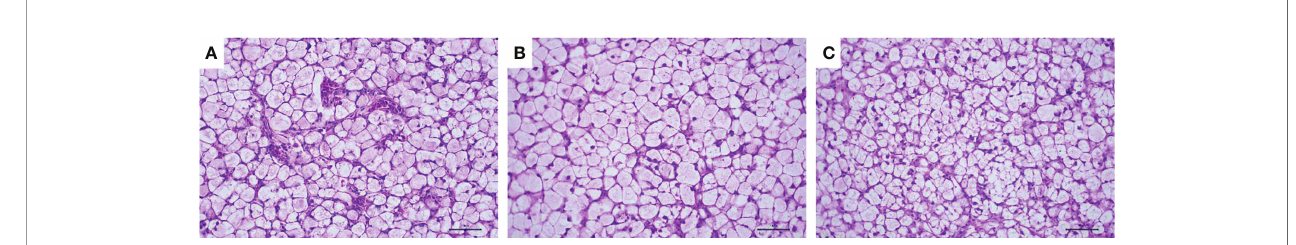
FIGURE 3 | Effect of dietary nano-curcumin on the liver histology (hematoxylin and eosin staining, original magni fi cation ×400) of largemouth bass after 60 days. (A) Liver from fi sh fed diet 0% nano-curcumin. (B) Liver from fi sh fed diet 0.1% nano-curcumin. (C) Liver from fi sh fed diet 0.2% nano-curcumin.